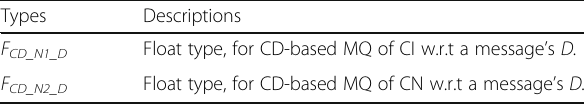
Table 7 Data types used in the model of